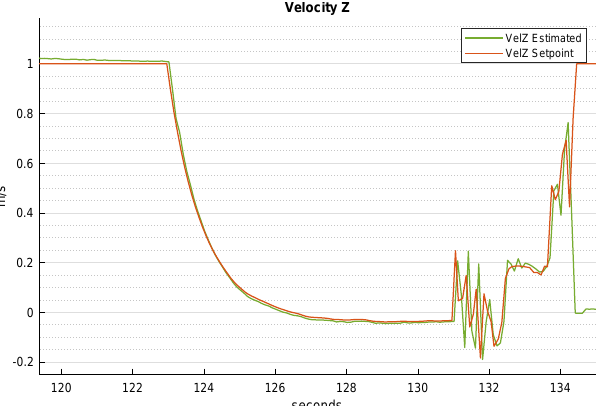
Figure 11. Time-wise behavior of the UAV z velocity and its setpoint during the whole landing